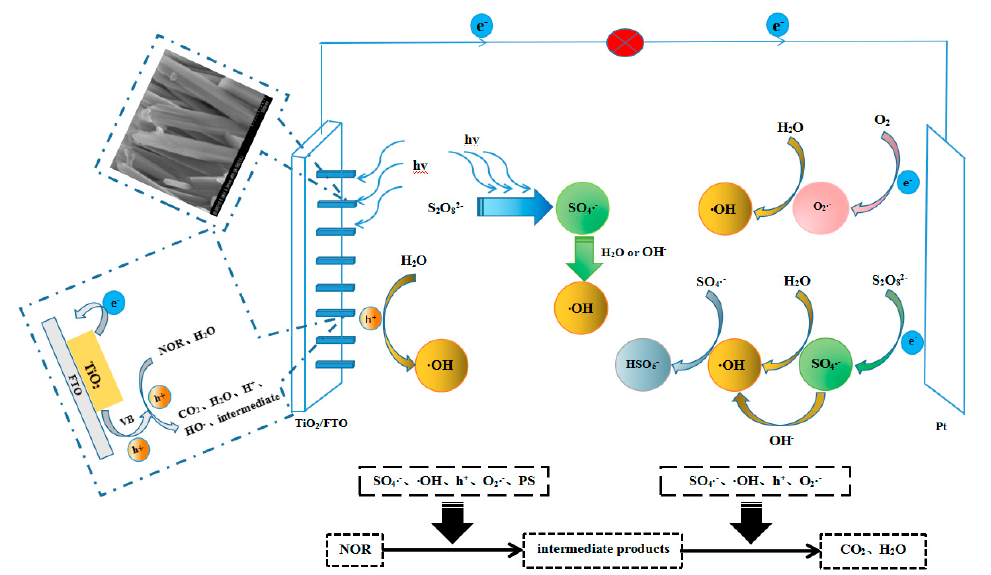
Scheme 1. Schematic illustration of PS activation, radicals’ generation, and NOR degradation pathway in PFC/PS system.